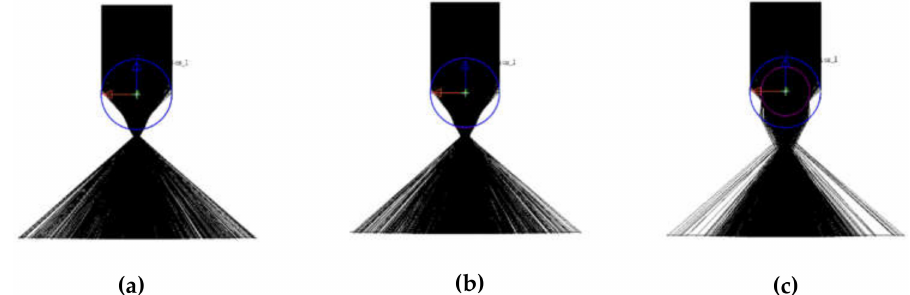
Figure 4. Ray behavior comparison of the ( a ) solid plastic (PMMA) homogenous spherical lens, ( b ) KF-97-500cs homogeneous spherical lens, and ( c ) CSSP